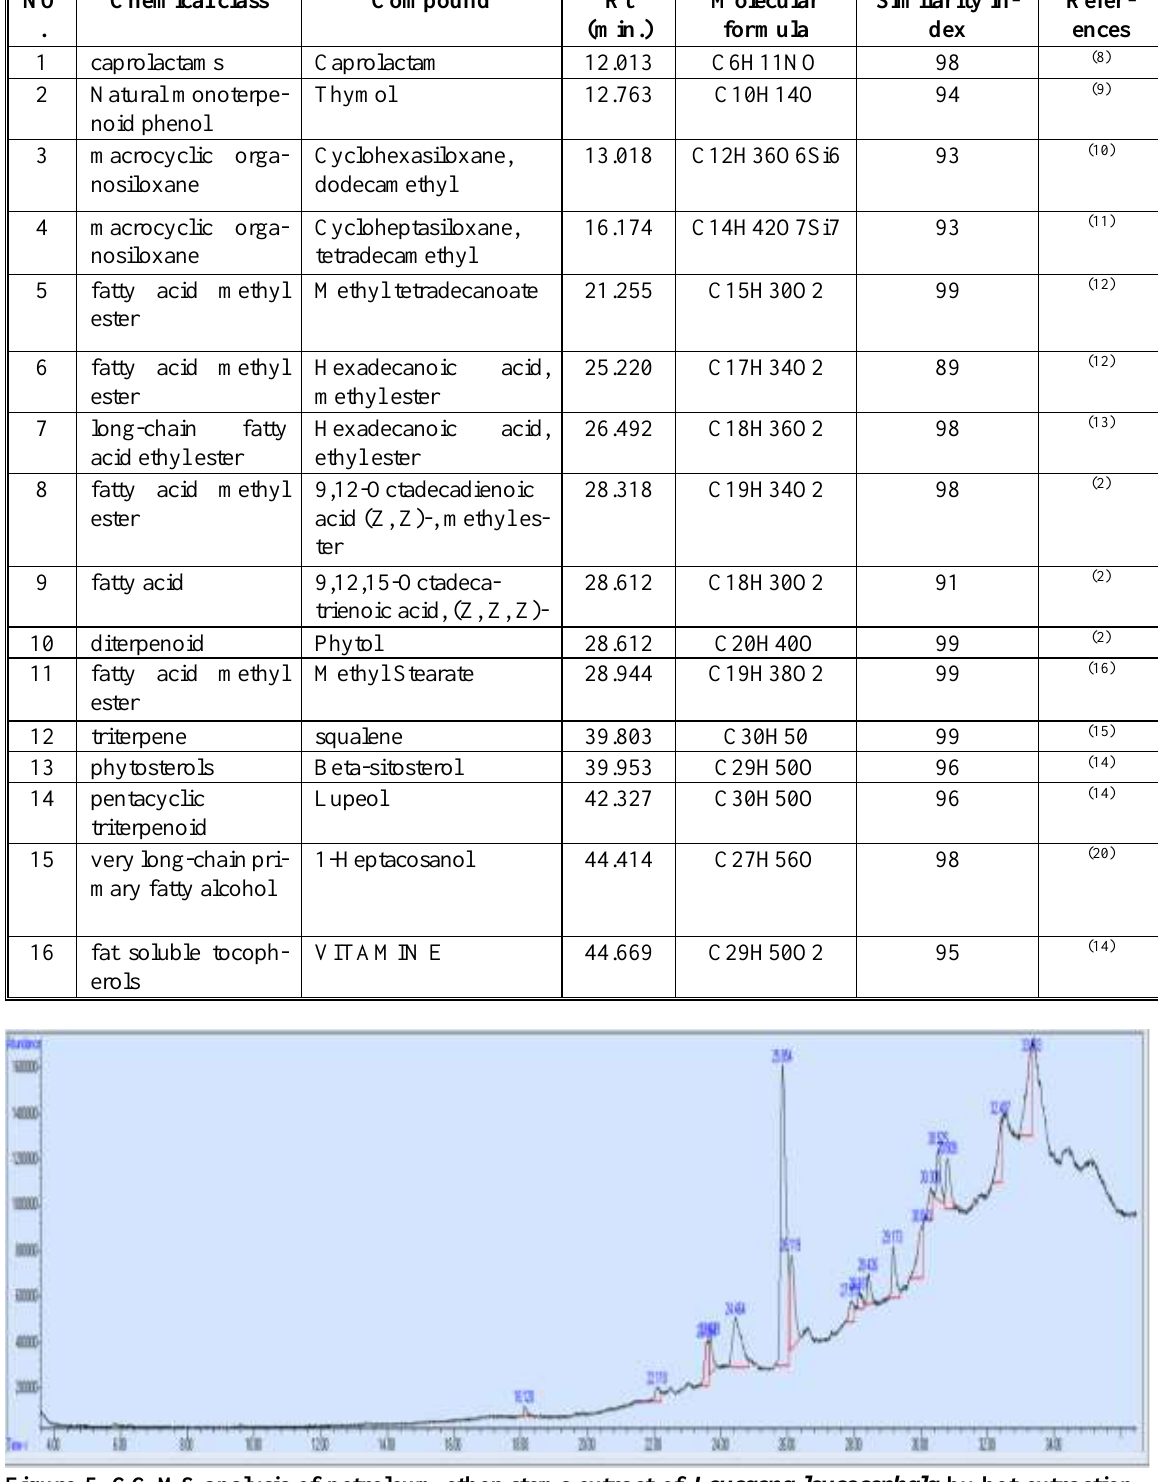
Figure 5. GC-MS analysis of petroleum ether stems extract of Leucaena leucocephala by hot extraction